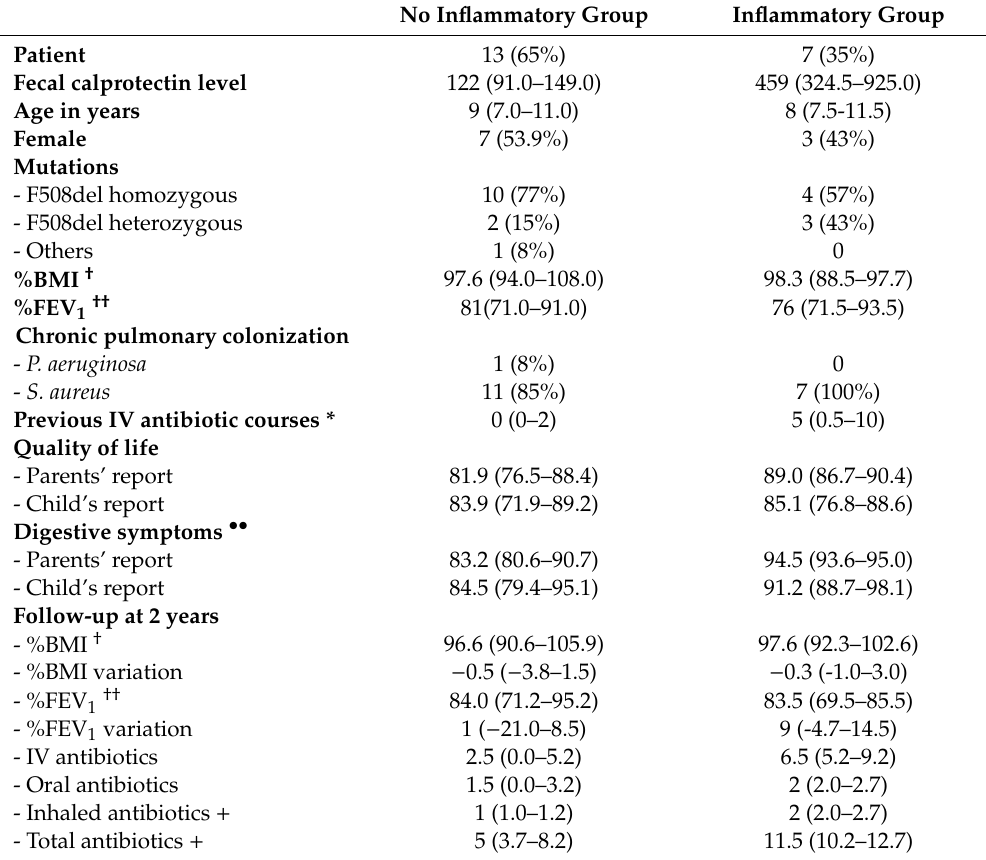
Table 1. Characteristics of patients with and without intestinal